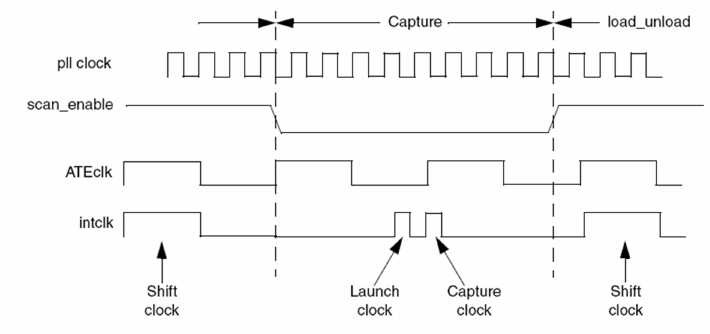
Figure 5. Timing waveform of on-chip clock